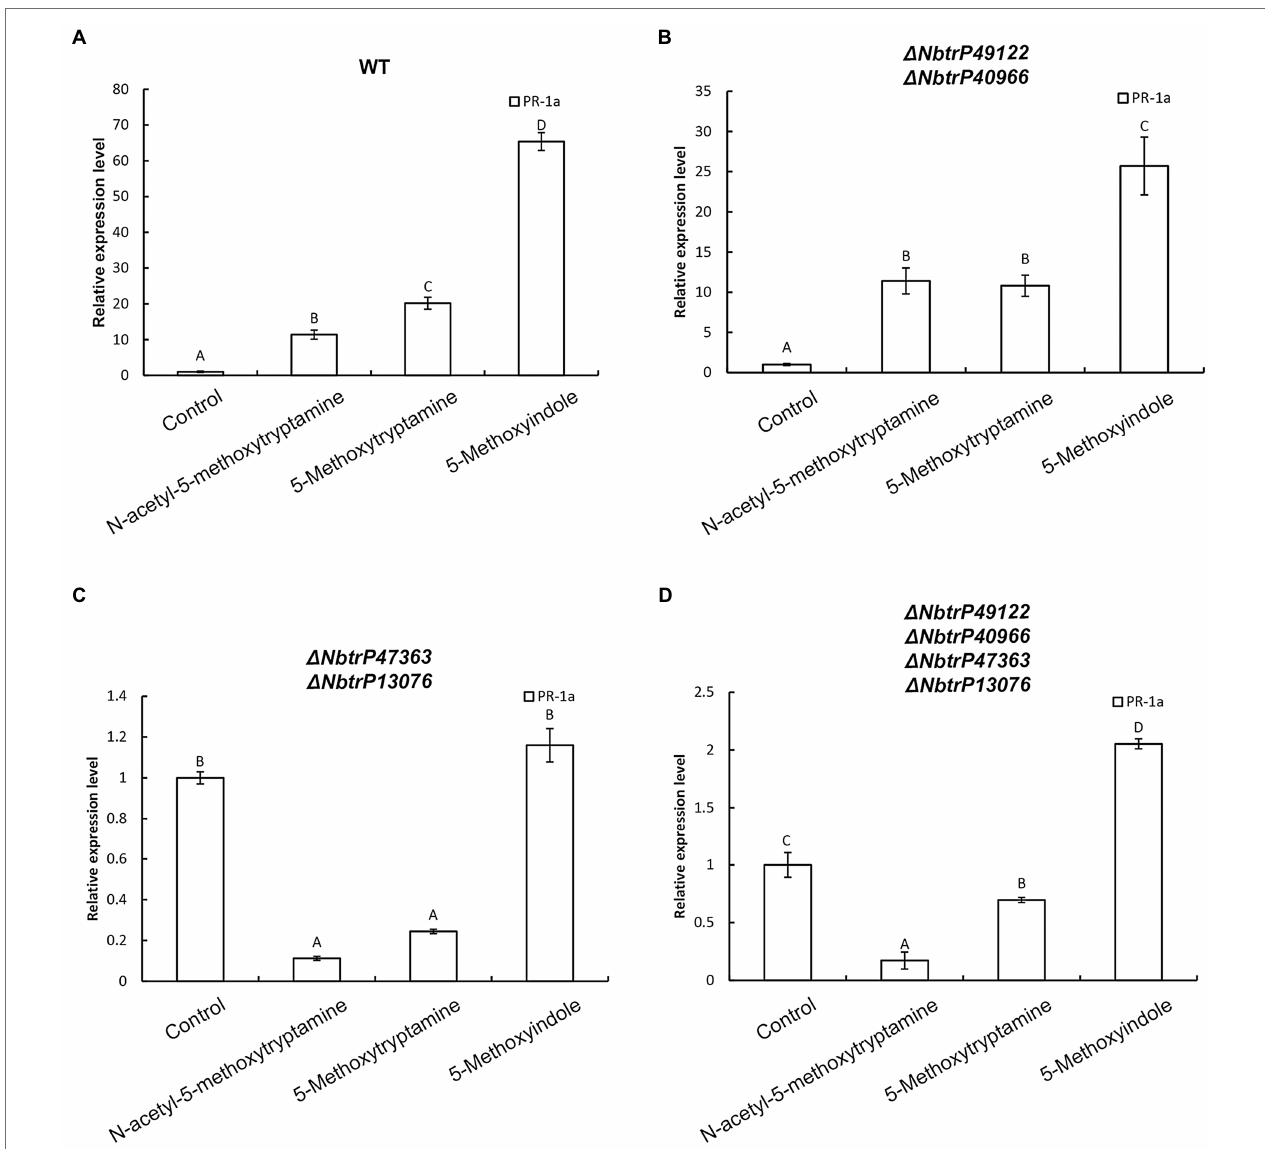
FIGURE 9 | The transmembrane receptors trP47363 and trP13076 play a key role in melatonin, 5-methoxytryptamin, and 5-methoxyindole activation of the SA-signaling pathway. MT, 5-methoxytryptamine, and 5-methoxyindole induced expression of the SA marker gene, PR-1a , in leaves of wild-type and VIGS mutants of N. benthamiana . (A) RT-qPCR analysis of PR-1a gene expression in response to MT, 5-methoxytryptamine, and 5-methoxyindole treatments in wild-type plants. Values were normalized to levels of EF-1a expression. Values represent the mean relative expression level (fold-change) with expression levels in the control set